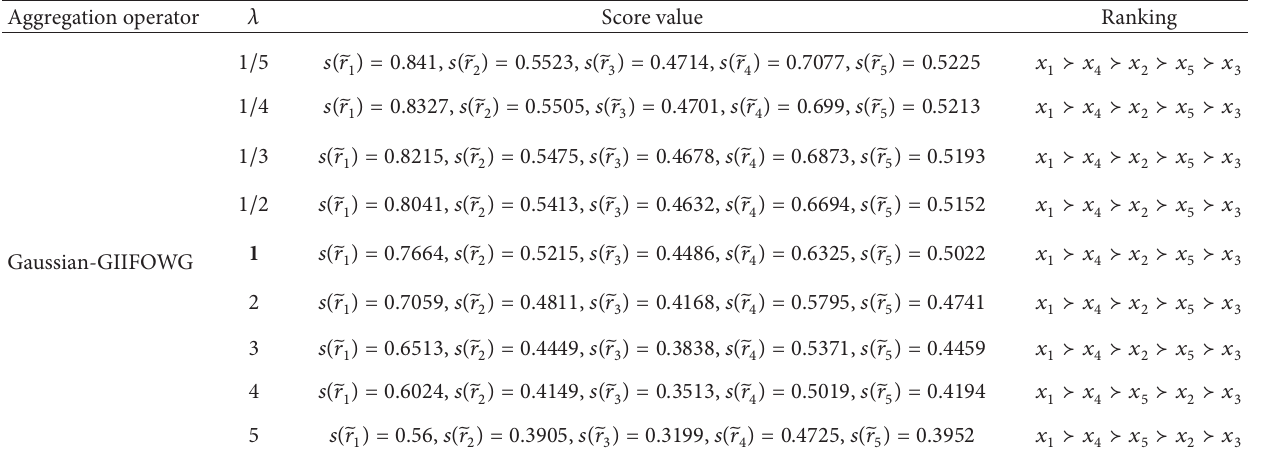
Table 12: Ranking results obtained by applying P-GIIFOWA on assessments given by 𝑑 1 . Aggregation operator 𝜆 Score value Ranking